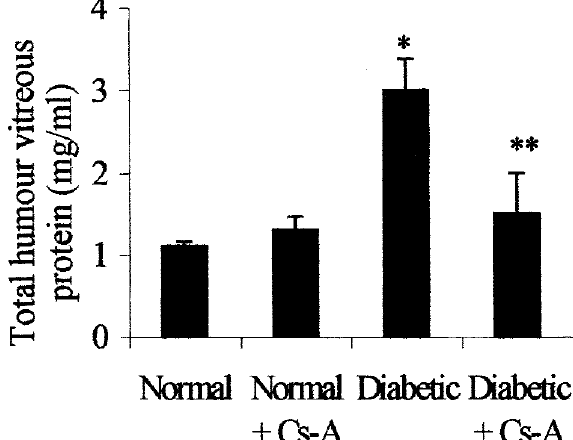
FIG. 6. Vitreous protein concentration. The protein concen- tration was determined according to the kit instructions. Data are mean ± SD values from 5 rats from each group. *Significant differences from normal rats ( p < 0.05). **Sig- nificant differences from Cs-A non-treated diabetic rats ( p < 0.05) (one-way ANOVA analysis, Dunnett’s